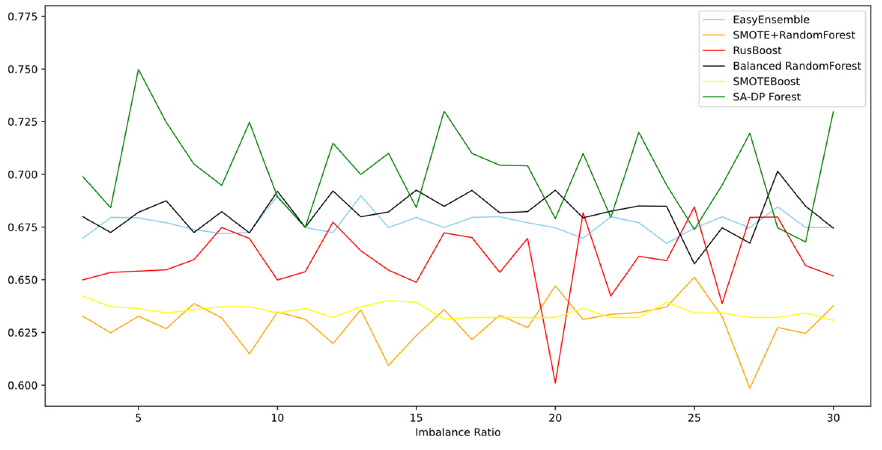
Figure 3. G-mean according to different imbalance ratios (German credit).